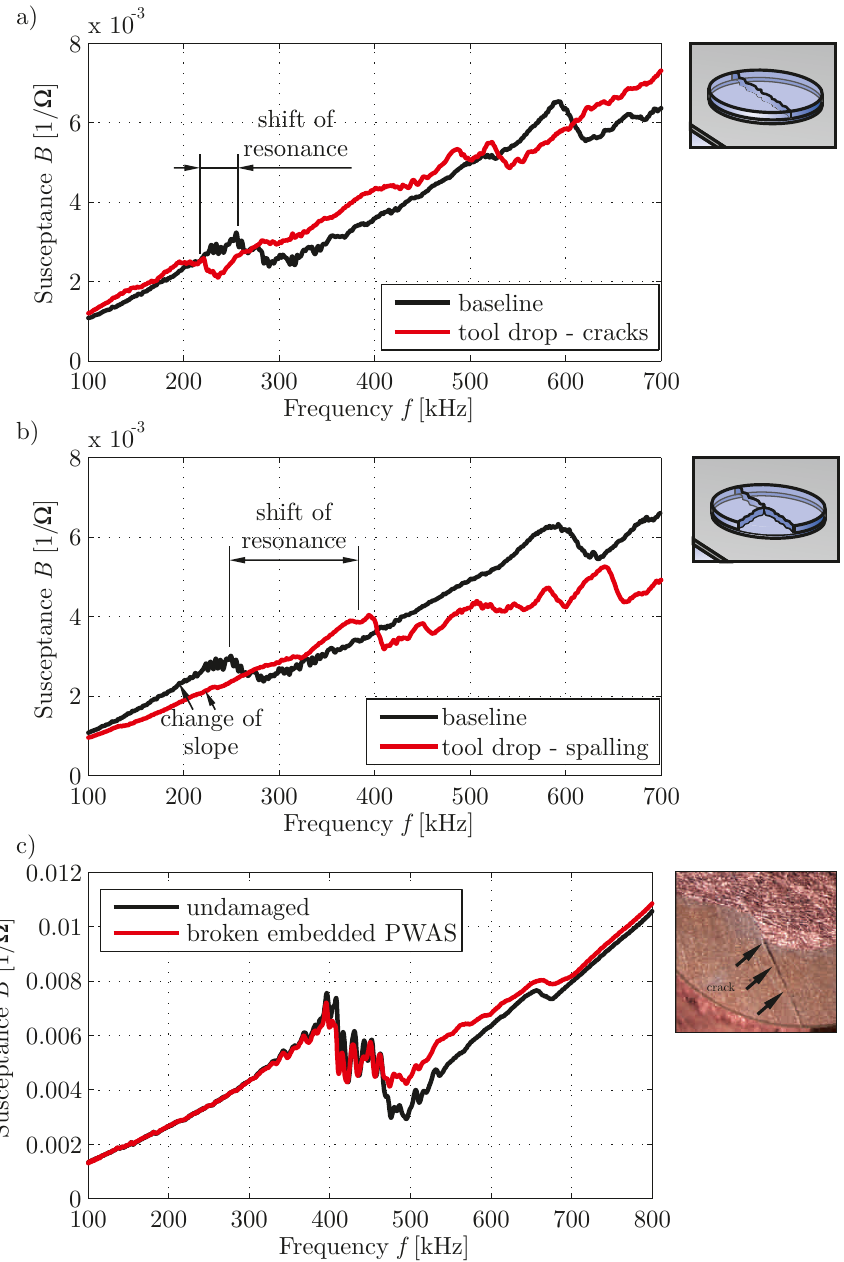
Figure 8. Susceptance spectra for the fault breakage: ( a ) Simple disc-shaped transducer, PIC 255, diameter 10 mm, thickness 0.5 mm, bonded to an aluminum plate, with cracks; ( b ) simple disc-shaped transducer, PIC 255, diameter 10 mm, thickness 0.5 mm, bonded to an aluminum plate, with cracks and spalling; ( c ) embedded transducer, PIC 255 material, type DuraAct, see [34], with